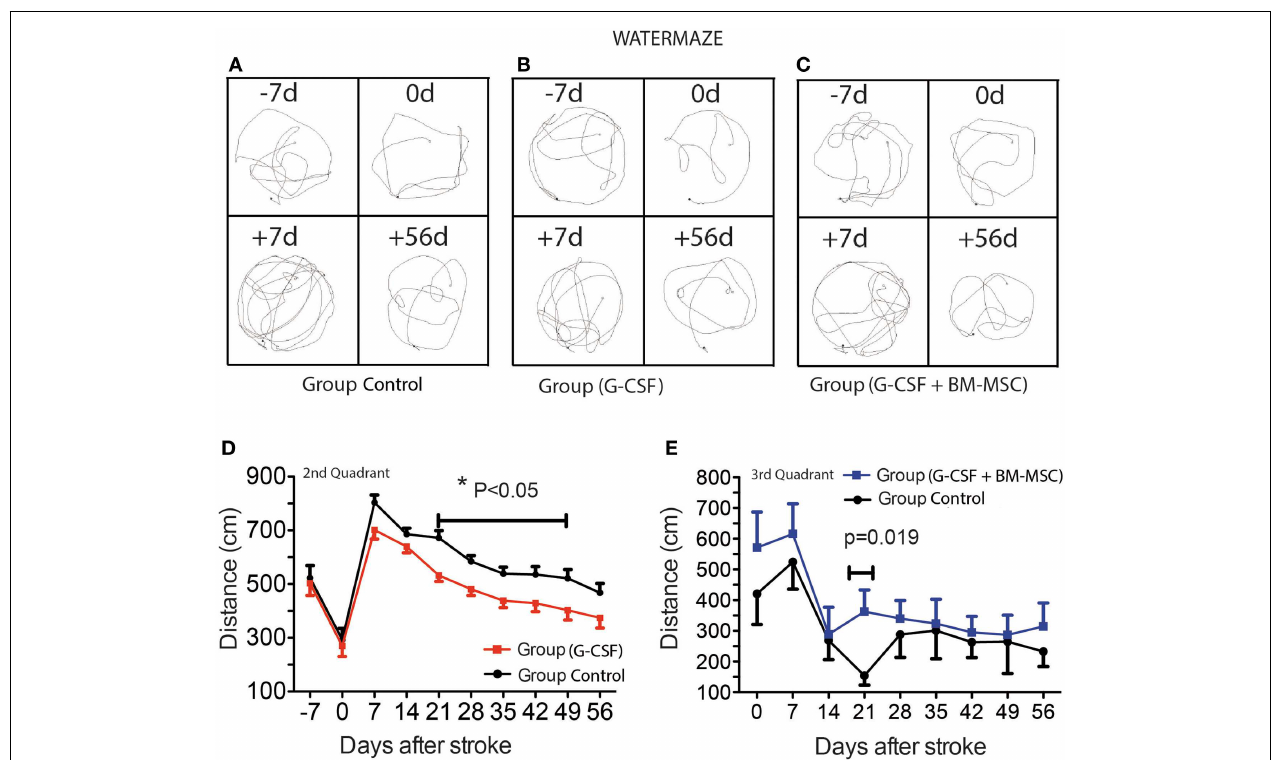
reference-memory between days 21 and 49 in the second quadrant [ (D) ; p = 0.05]. However, in the third quadrant, the performance was temporarily improved between days 14 and 28 in the group treated with G-CSF + BM MSC as compared to the control group [ (E) ; p = 0.019]. Data are given as mean ± SEM.